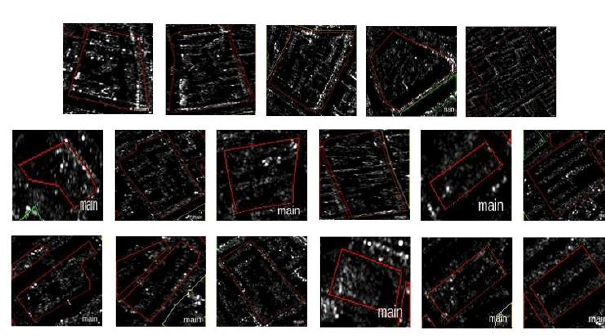
Figure 4. Building samples in SAR image: intact